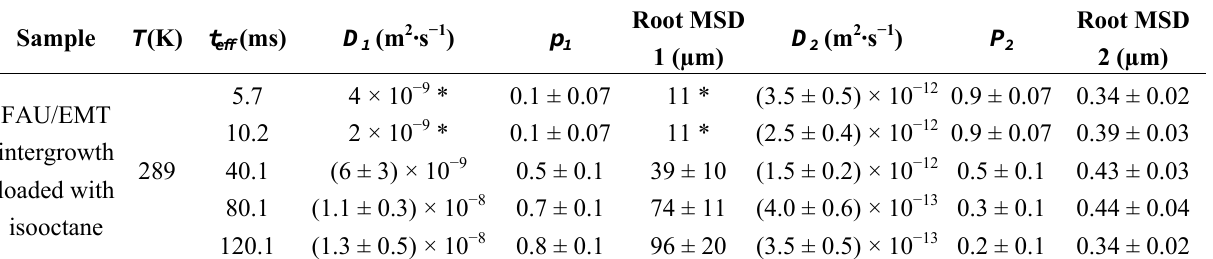
Table 3. Results of fitting of the PFG NMR attenuation curves measured for isooctane diffusion in the FAU/EMT intergrowth at T = 289 K by Equation (2) with n = 2. The ) were obtained from the attenuation curves measured at the intraparticle diffusivities ( D 2 extended gradient range (not shown in Figure 5). Star (*) indicates values with a large (in the range of a factor of 2–4) experimental